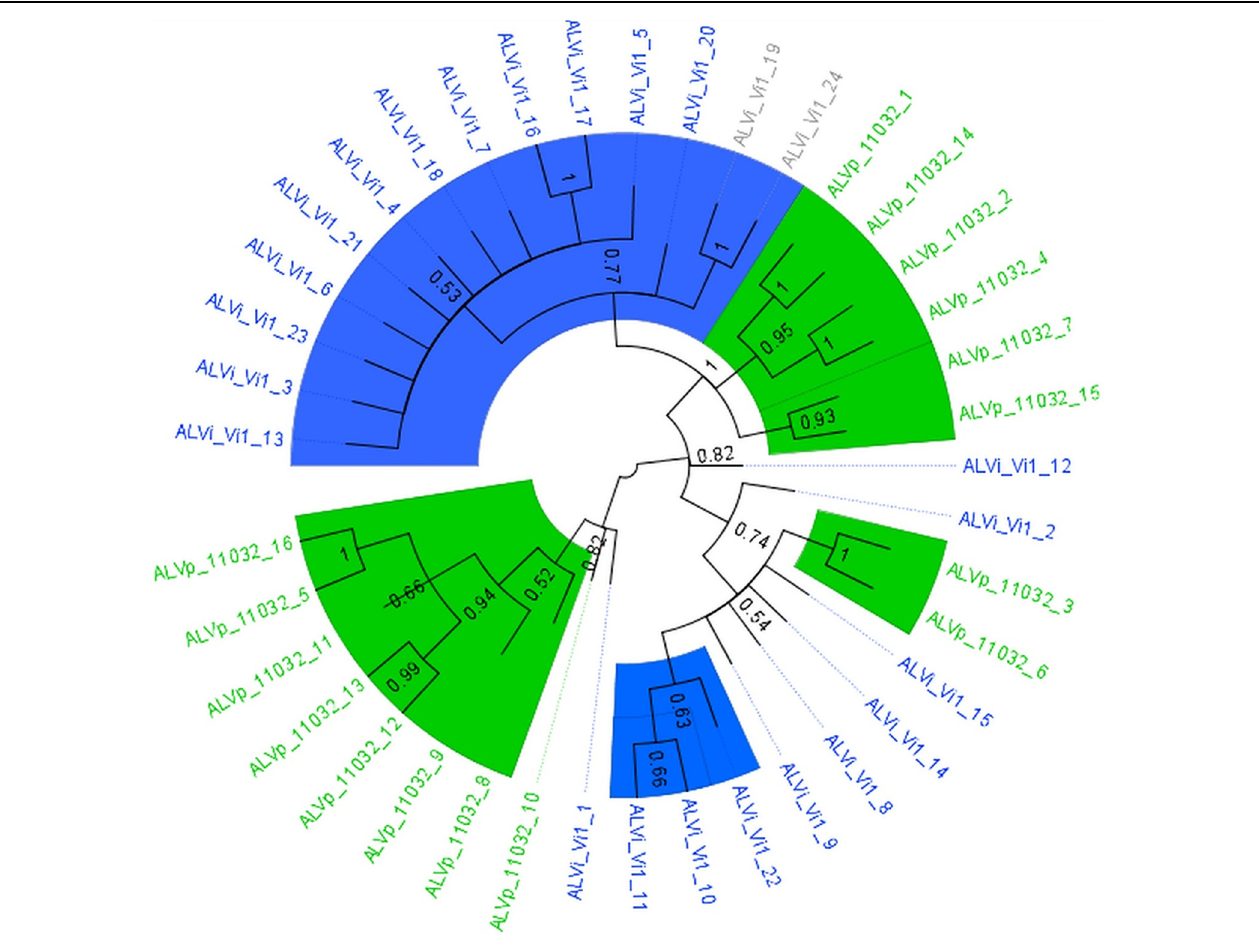
FIGURE 3 | Maximum likelihood tree calculated on multiple sequence alignment of ALVi and ALVp predicted protein sequences from V. inaequalis isolate Vi1 and V. pirina isolate 11032 using a WAG substitution model and 500 bootstrap tests. Species-specific clades with over 75% bootstrap support are highlighted with colored wedges. Sequence names in green are from V. pirina isolate 11032 and blue from V. inaequalis Vi1. Gray sequence labels represent Vi1 genes for which we have no evidence for gene expression from in planta or in vitro